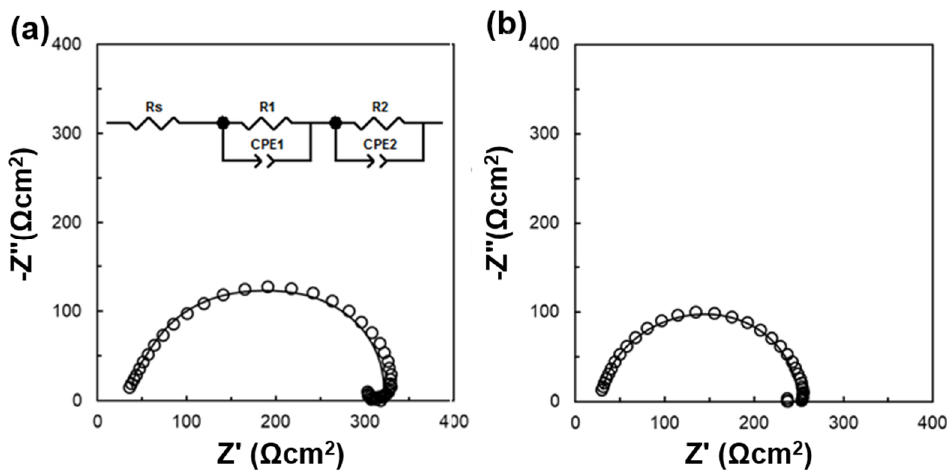
Figure 5. Nyquist plots of perovskite solar cells (PSCs) based on ( a ) TiOx and ( b ) TiO 2 in the dark at a DC bias of 0 V. A 1–V AC signal was applied with a frequency range of 20 Hz–1 MHz. The inset shows the equivalent circuit model of the resultant devices.